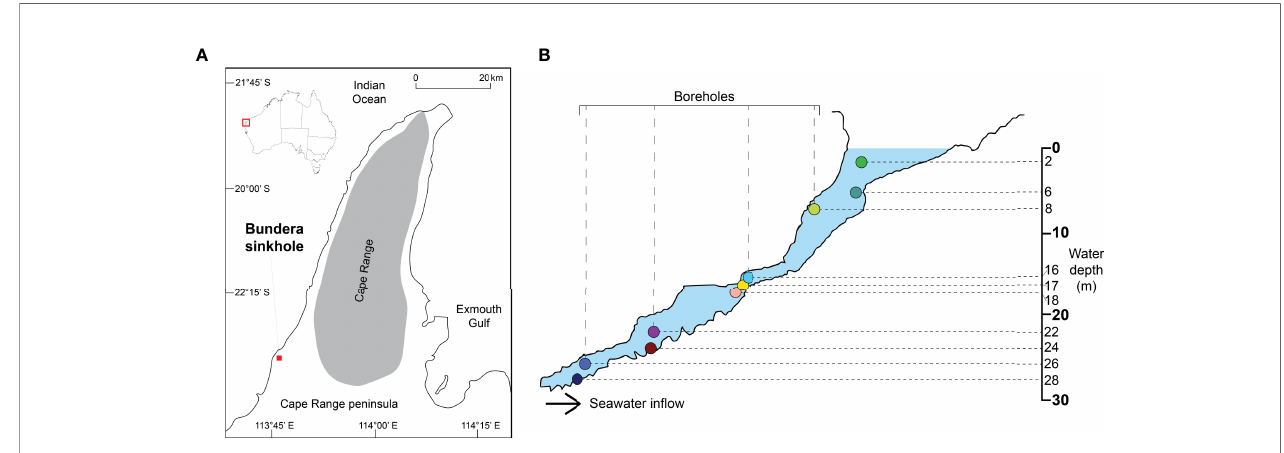
FIGURE 1 | (A) Location of the Bundera sinkhole at the Cape Range peninsula in Western Australia, adapted from (Gadagkar et al., 2008). (B) Topology of the sinkhole and sample extraction sites for both the physicochemical data and microbial mass study, adapted from Humphreys, 1999. For each depth sampled the colour arbitrarily assigned here is consistently used for all fi